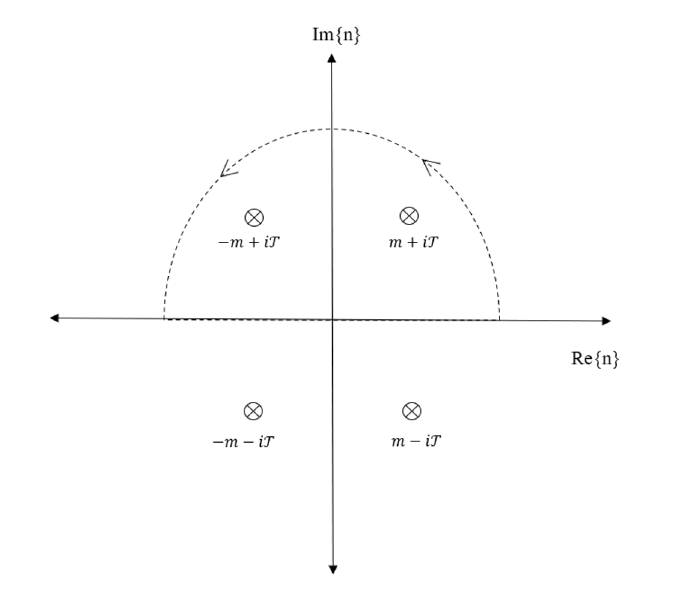
Figure 3. Pole structures of the integral